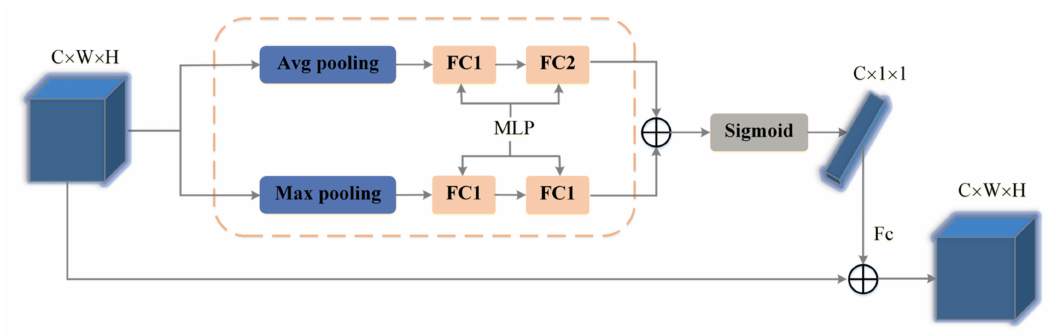
Figure 4. Channel attention mechanism module.